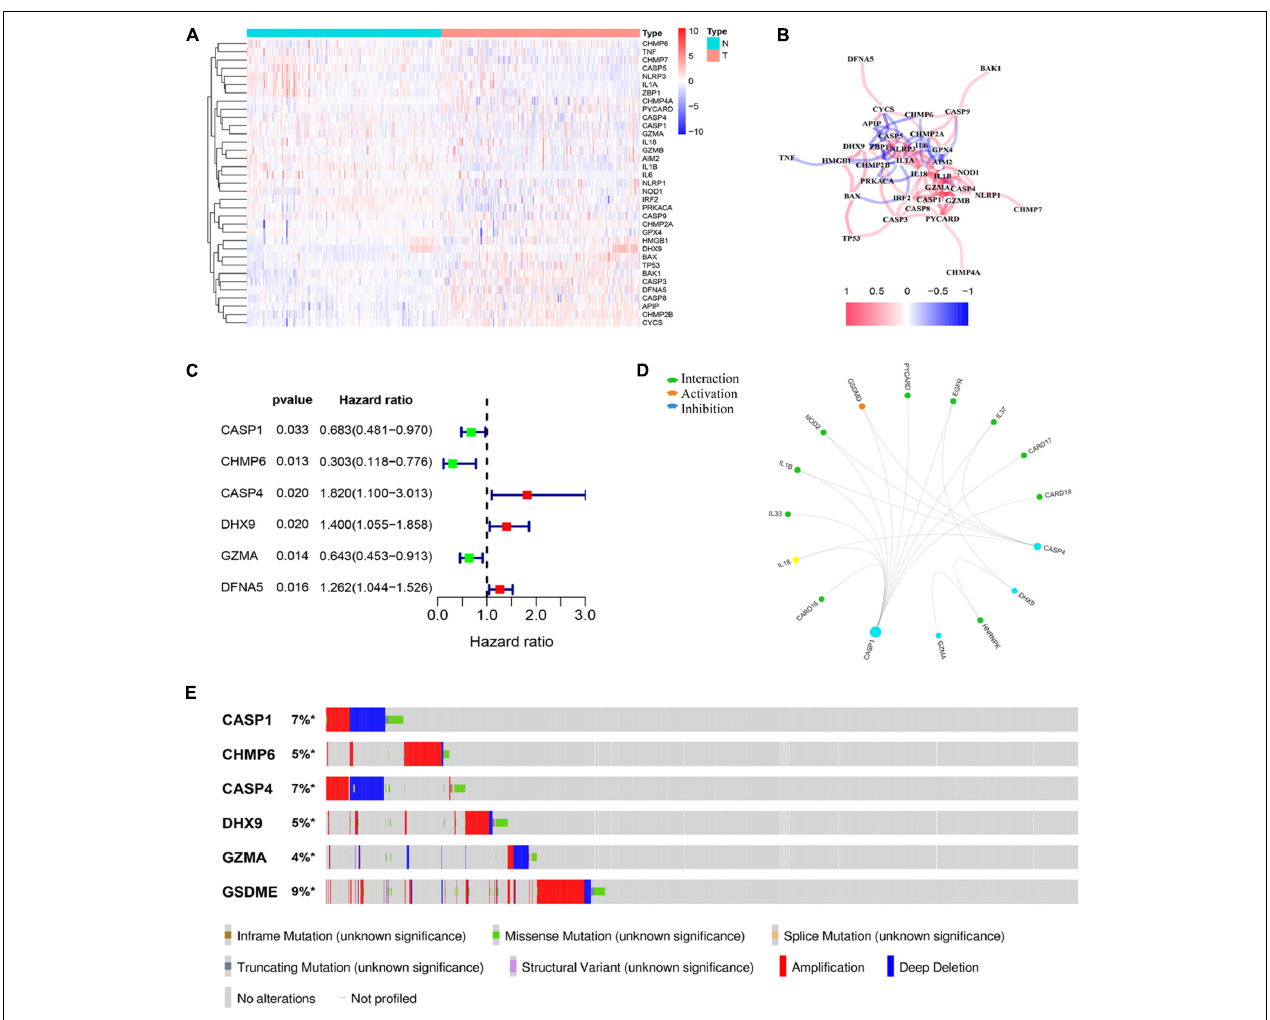
FIGURE 1 | Identification of prognostic differently expressed genes (DEGs) between hepatocellular carcinoma (HCC) and normal liver tissues. (A) Heat map of differently expressed pyroptosis-related genes (PRGs) between the normal liver and HCC tissues. (B) The correlation network of candidate PRGs. (C) Forest plots showing the results of the univariate Cox analysis between gene expression and overall survival (OS). (D) Protein–protein interaction (PPI) analysis to explore the potential association among the prognostic DEGs. (E) The landscape of genetic alteration profiles of six genes in CCLE, obtained from the cBioPortal